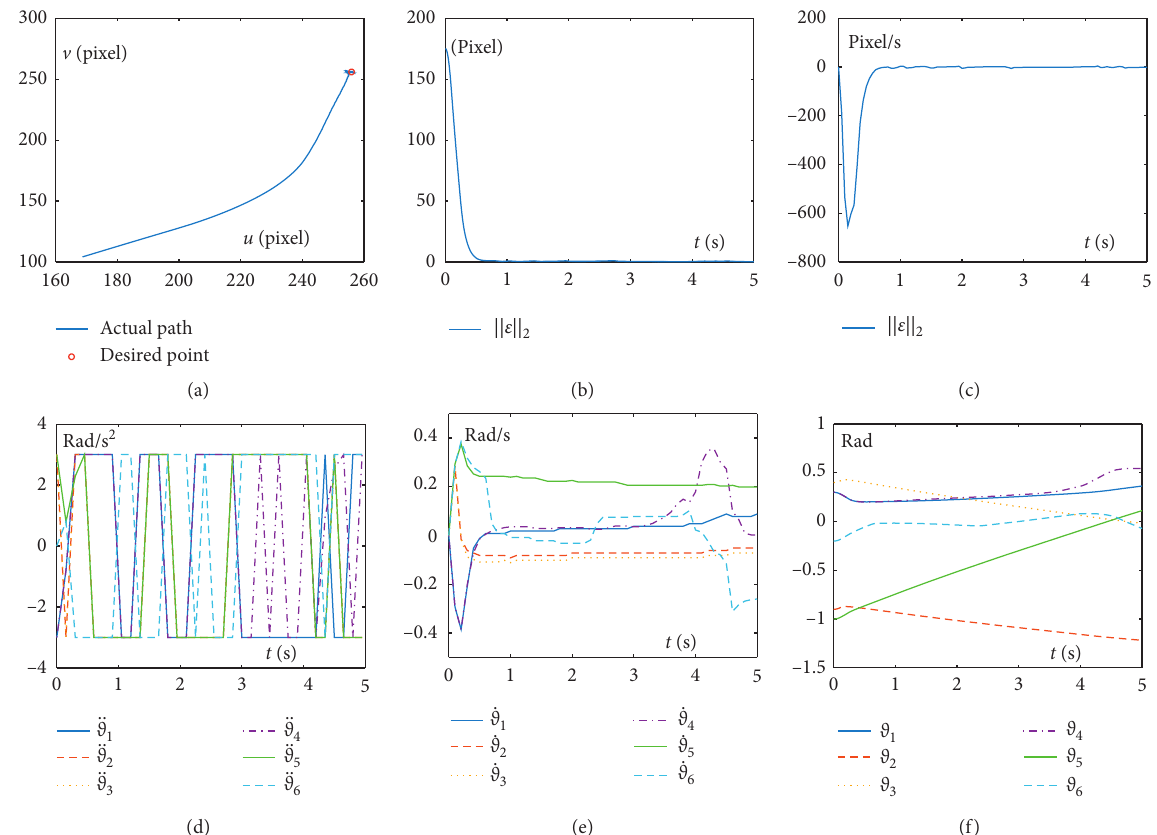
Figure 3: Simulation results on the PUMA 560 manipulator driven by the quadratic programming scheme (11)–(14) aided with GRNN (26) for the visual servoing task with execution time T � 5s. (a) Actual path and desired point in image space. (b) Time history of 2-norm of error ε . (c) Time history of 2-norm of error _ ε . (d) Time history of joint acceleration. (e) Time history of joint velocity. (f) Time history of joint angle.